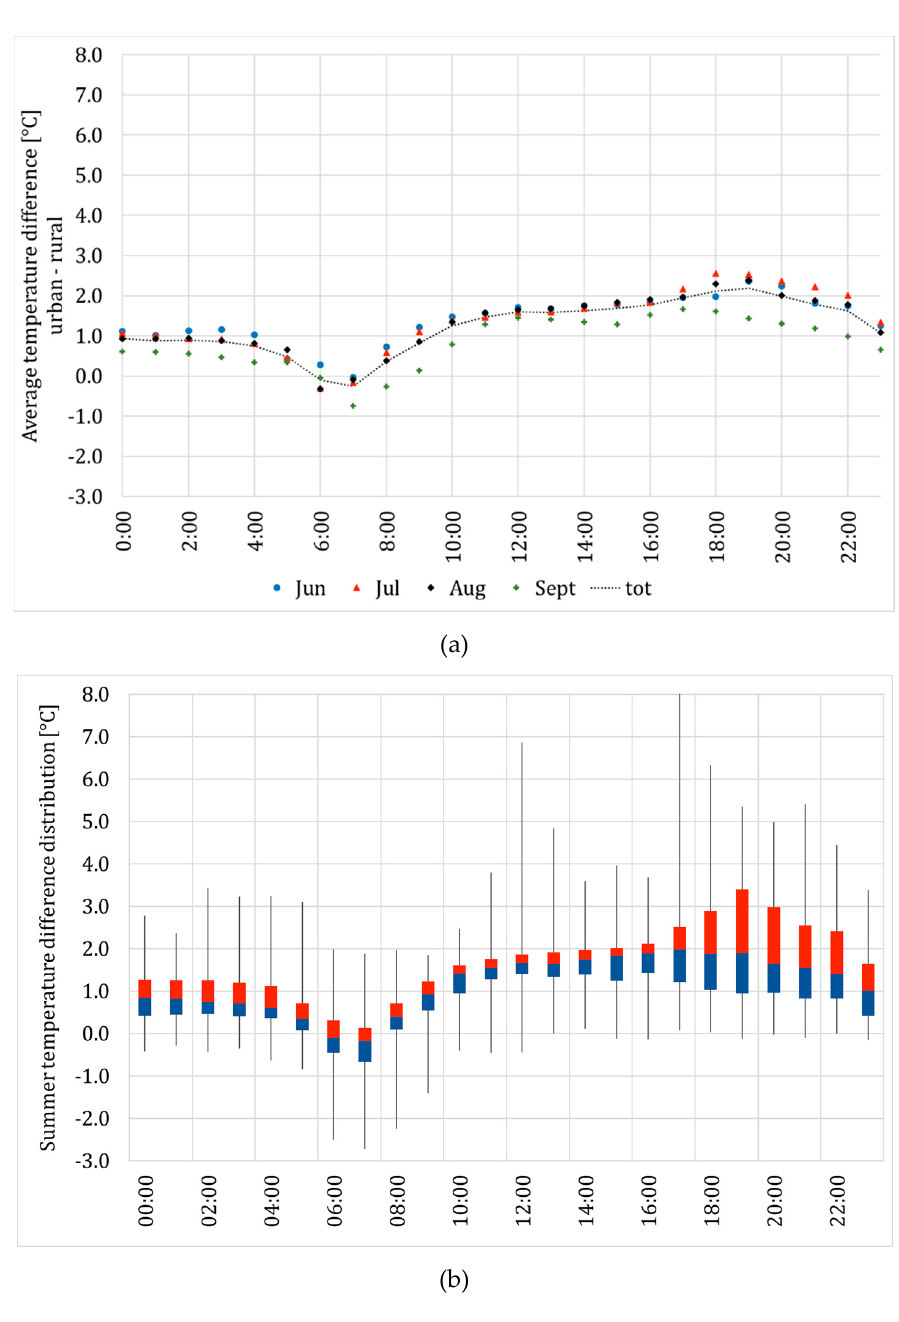
Figure 7. Urban–rural daily temperature difference: ( a ) average monthly trends; ( b ) box plot showing minimum, maximum, and quartiles for the summer season.